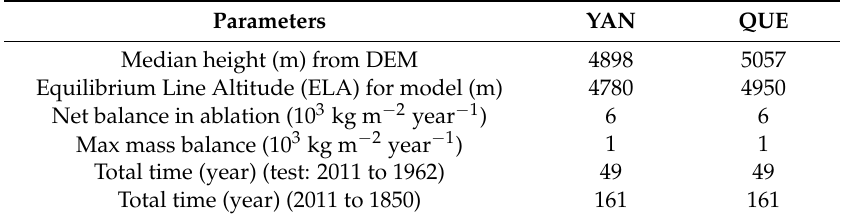
Table 1. Input parameters for the cellular automata model employed in this